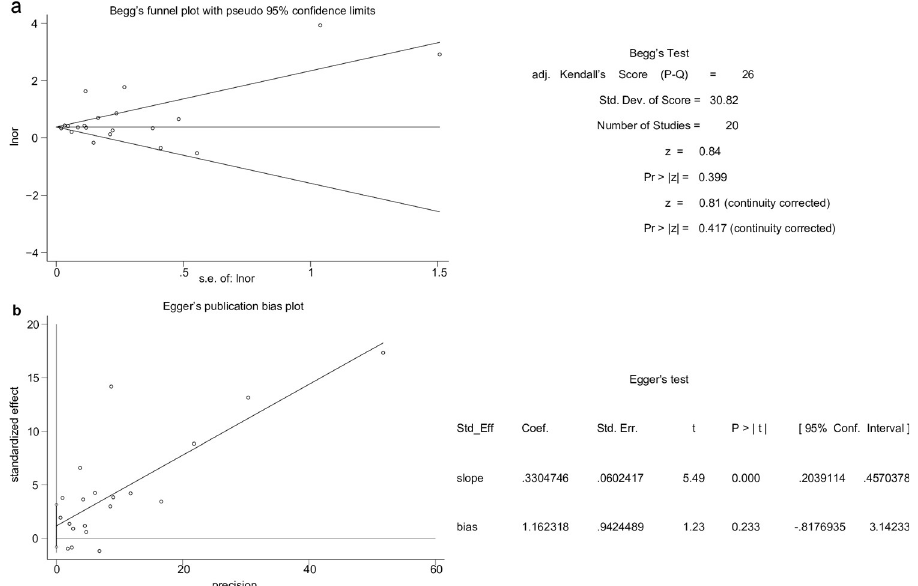
Fig 4. Publication bias assessment of eczema associated with anxiety/depression. ( a ) The horizontal line refers to pooled effect estimates, and the two oblique lines indicate the pseudo 95% confidence intervals. ( b ) Egger’s test showed the absence of significant publication bias concerning eczema associated with anxiety/depression. Detailed information for both the tests is shown on the right side.